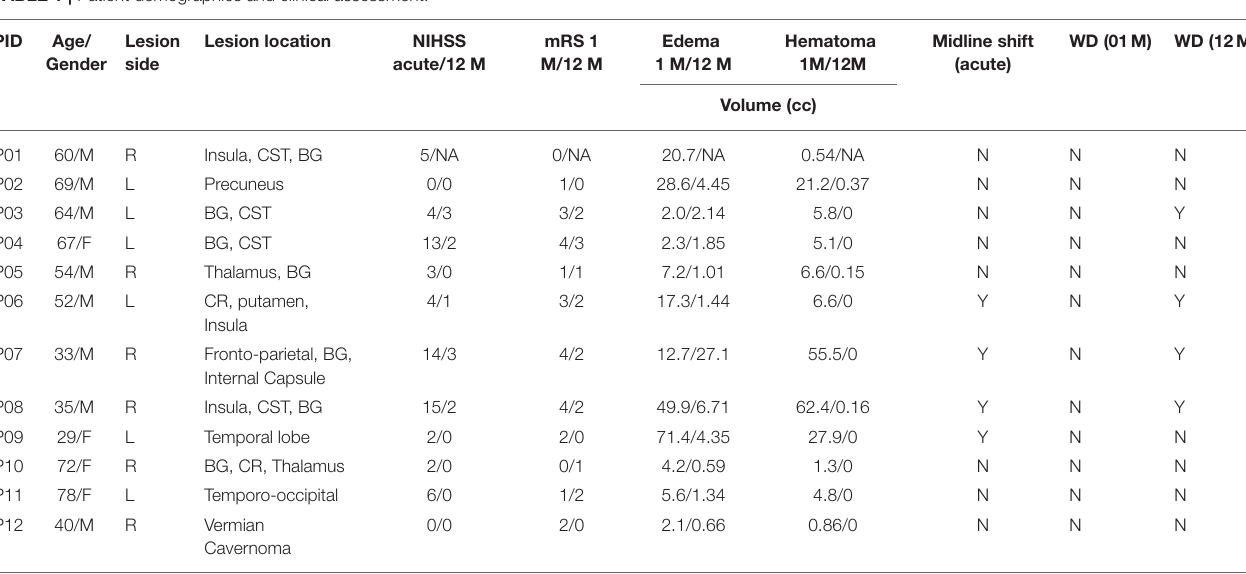
TABLE 1 | Patient demographics and clinical